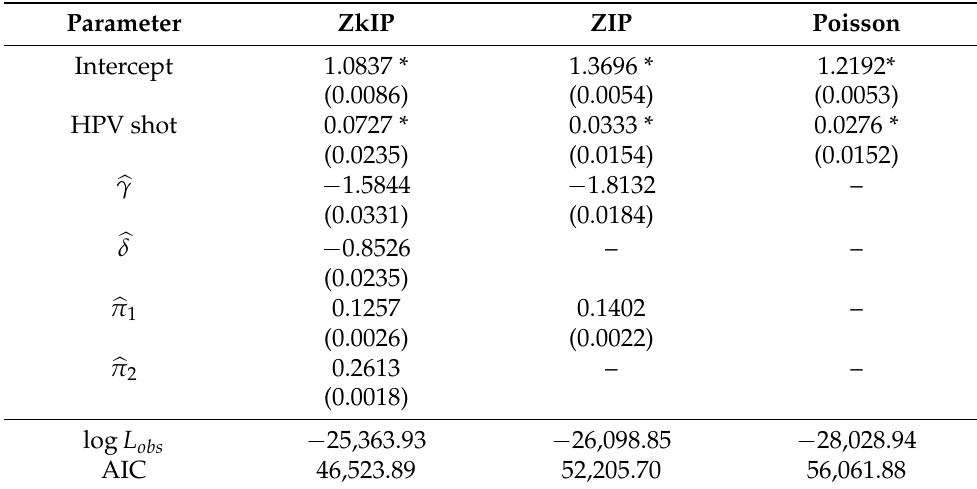
Table 4. Estimates and standard errors for pap smear data. The significant regression coefficients are marked with an asterisk.